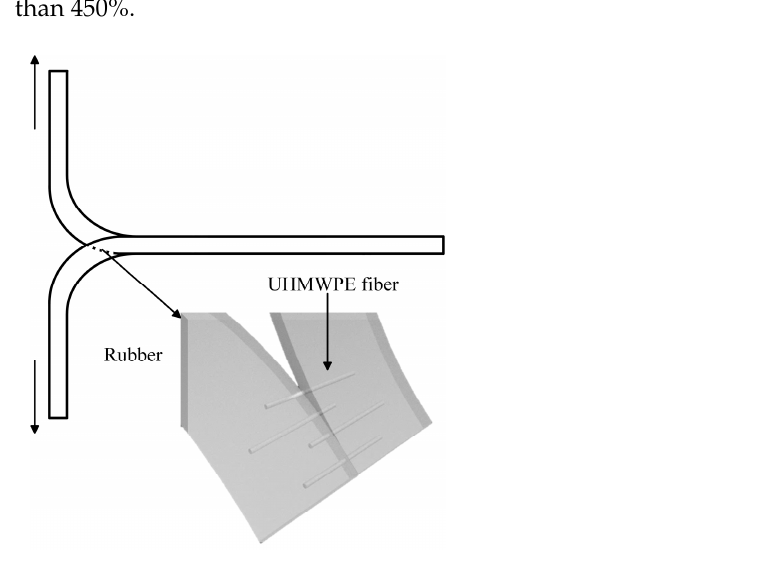
Table 5. Mechanical properties of fiber/NR composites with different formulas.